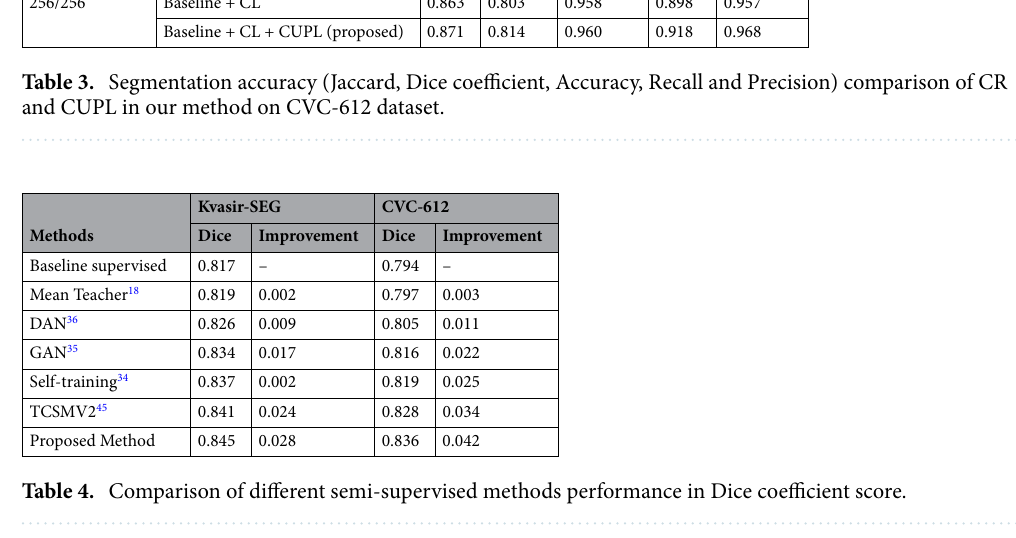
Table 4. Note that the Mean-Teacher method 18 is similar to our method “Baseline supervised + CL”; however, consistency loss is not included, and only the exponential average weight of the model is used for the prediction. We implement all methods mentioned above with their original settings and evaluate them on Kvasir-SEG and CVC-612 datasets. For the Kvasir-SEG dataset, we utilize 50 labeled and 750 unlabeled images. Similarly, we use 64 labeled images and 448 unlabeled images for CVC-612 images. Table 3 shows the dice coefficient score on